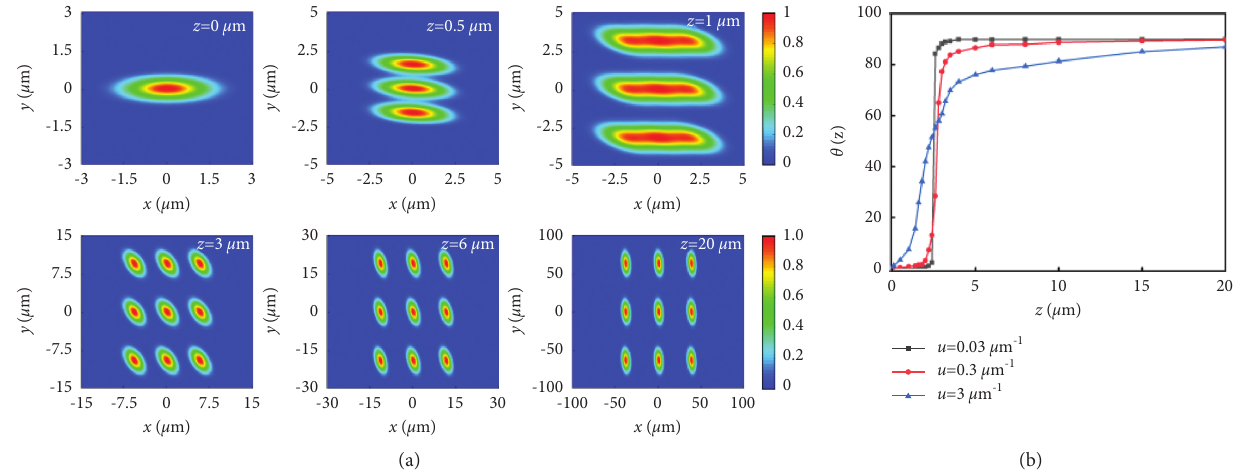
Figure 1: Variation of the spectral intensity and rotation angle of a TGSMA beam; (a) spectral intensity distribution at several propagation distances in turbulent biological tissue while biological tissue parameters are chosen, D f � 2.60, l c � 10.24 μ m; (b) rotation angle versus propagation distance z for different twisted strengths in turbulent biological tissue while biological tissue medium parameters are chosen, D f � 2.60, l c � 10.24 μ m.